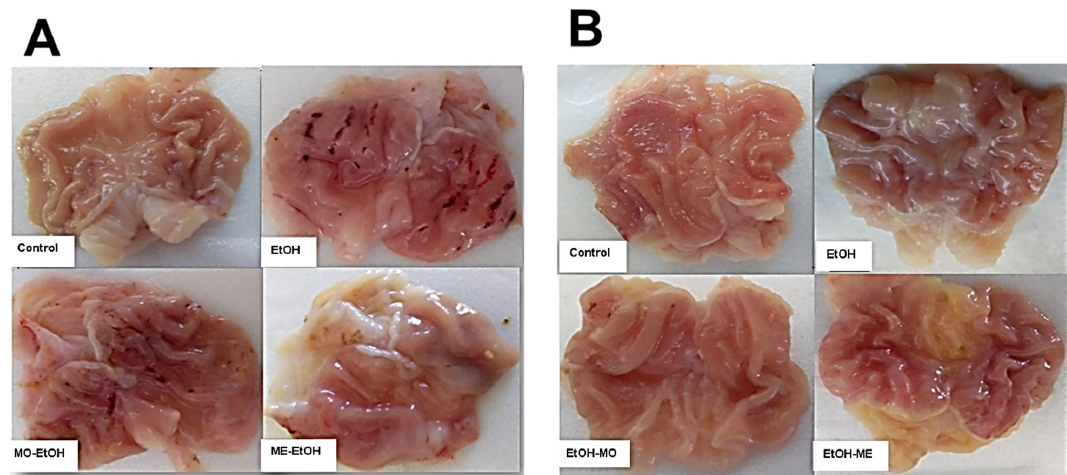
Figure 1. Gastric macroscopic lesions. ( A ) Preventive experiment: Control: showed the normal healthy pink color of gastric mucosa, normal gastric wall with normal mucosal thickening. No evident inflammation or ulcer. EtOH: stomach exhibited marked gross mucosal lesions, longitudinal hemorrhagic strikes of different sizes, and petechial lesions showed ulcerative inflammation associated with mucosal thinning. MO-EtOH showed mild hemorrhagic mucosal lesions and mild congestion. ME-EtOH; showed few congested mucosal lesions. ( B ) Treatment experiment: Control: showed healthy mucosa, normal folding, and normal thickening. No ulcer was recognized. EtOH: showed no mucosal lesions, moderate congestion, and hyperemia, with evidence of healing. EtOH-MO: showed a minute vascular response, no toxic or deteriorating effects with normal thickening as an evidence of healing. EtOH-MO: showed no hemorrhagic lesions with normal thickening as evidence of